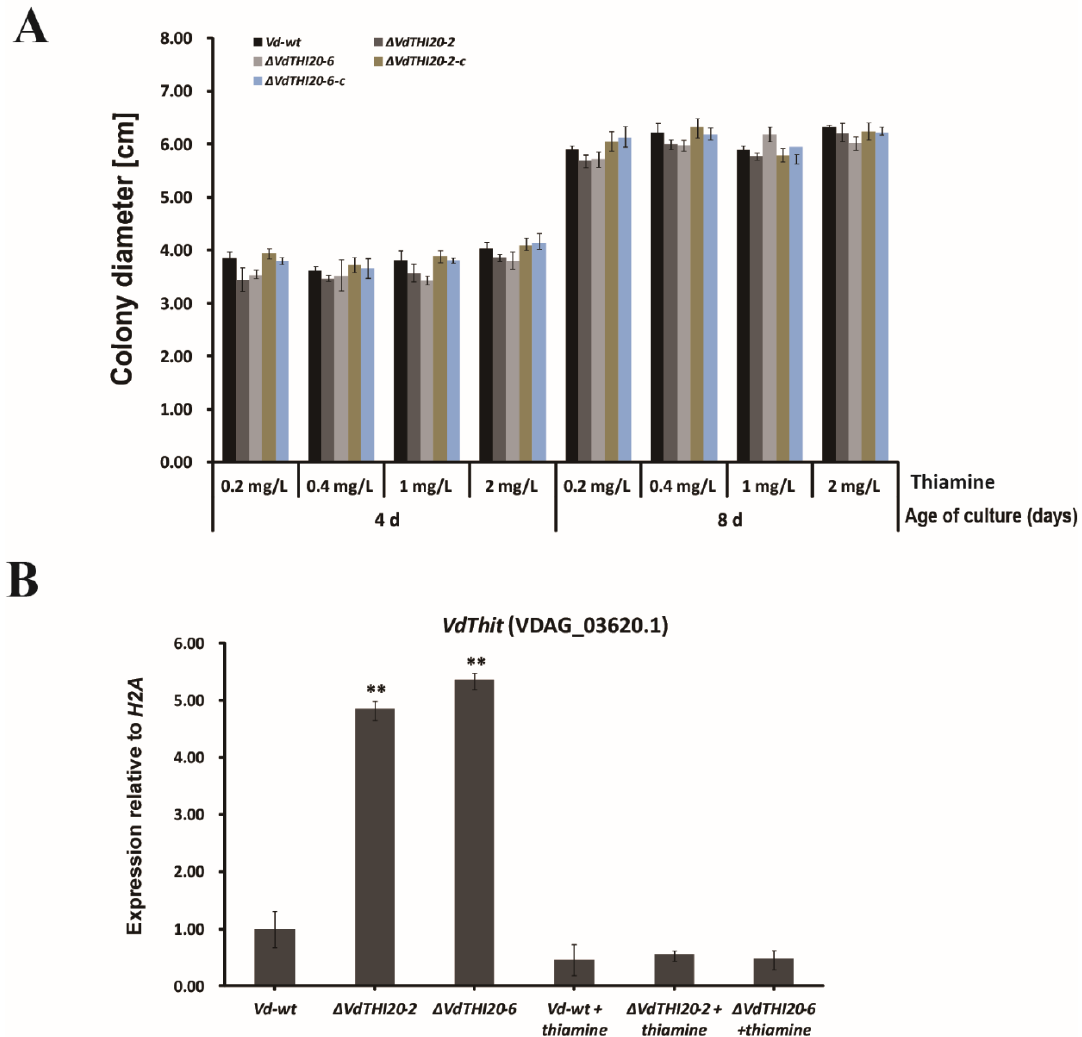
Figure 4. Exogenous thiamine recovered the hyphal growth of ΔVdTHI20 mutants on Czapek–Dox agar plates. ( A ) Colony diameters of the Vd-wt strain, ΔVdTHI20 mutant strains ( ΔVdTHI20-2 and ΔVdTHI20-6 ), and complemented strains ( ΔVdTHI20-2-c and ΔVdTHI20-6-c ) supplemented with exogenous thiamine (0.2 mg/L to 2 mg/L) were measured at 7 dpi. ( B ) The expression of VdThit in the Vd-wt strain and ΔVdTHI20 mutant strains with or without exogenous thiamine. Values are means ± standard deviation of three independent experiments performed in duplicate. Asterisks (**) indicate significant differences by Student’s t test at P < 0.01.